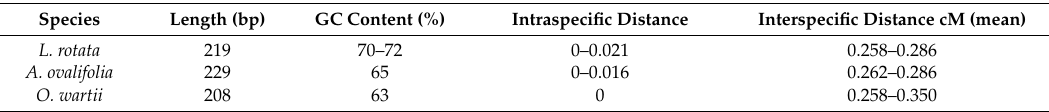
Table 1. The Sequence information and intra/inter-specific genetic distance of internal transcribed spacer 2 (ITS2).